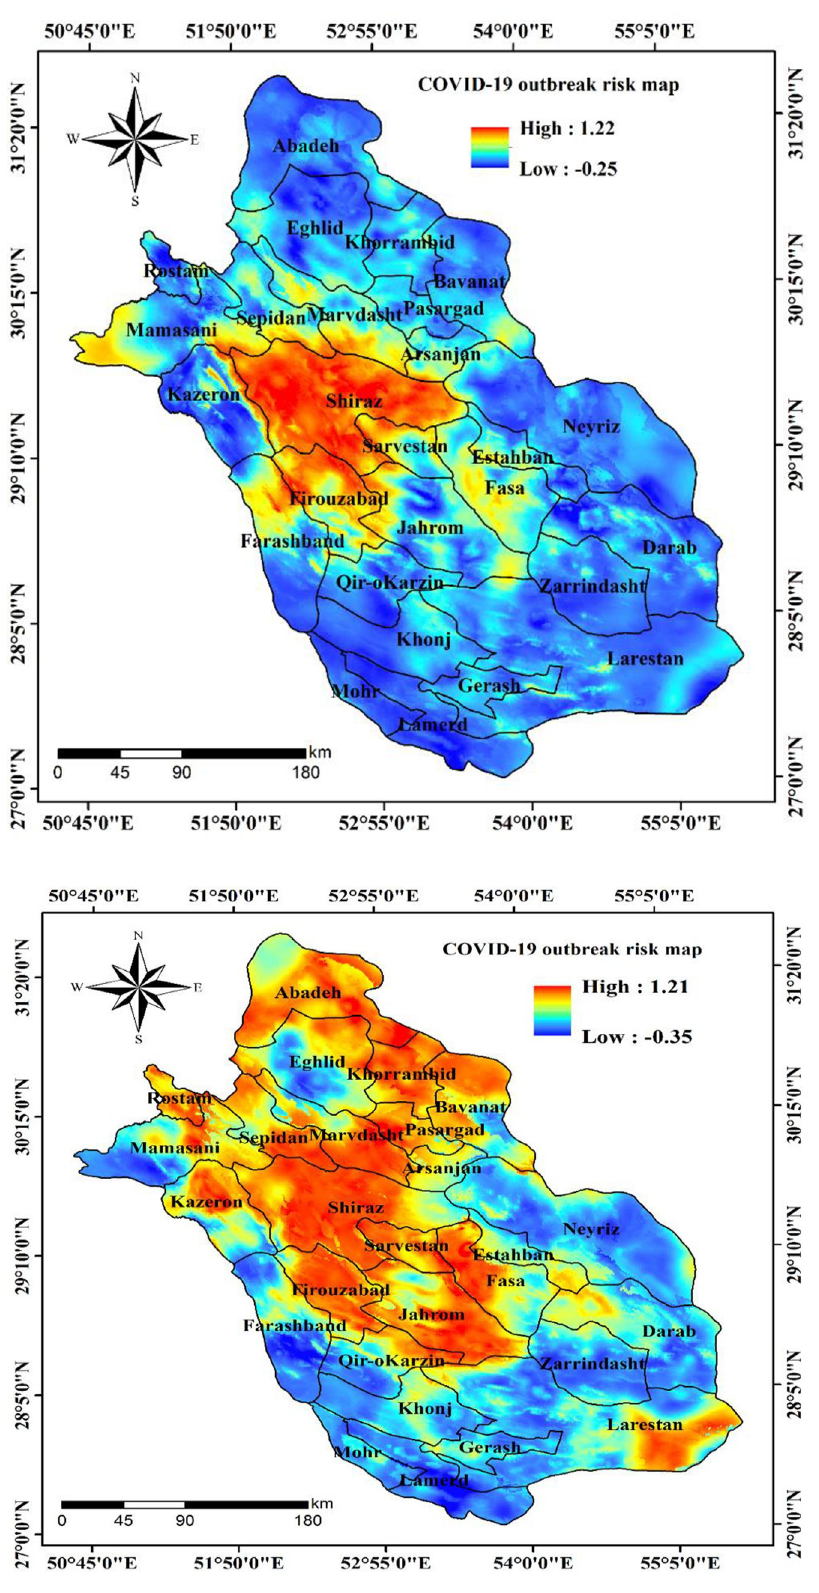
Fig 7. The COVID-19 outbreak risk map a) on March 29, 2020 and b) on April 10, 2020. https://doi.org/10.1371/journal.pone.0236238.g007 PLOS ONE | https://doi.org/10.1371/journal.pone.0236238 July 28,